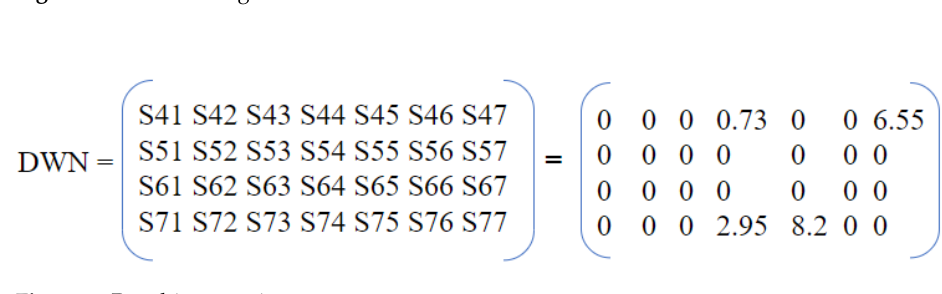
Figure 6. Resulting